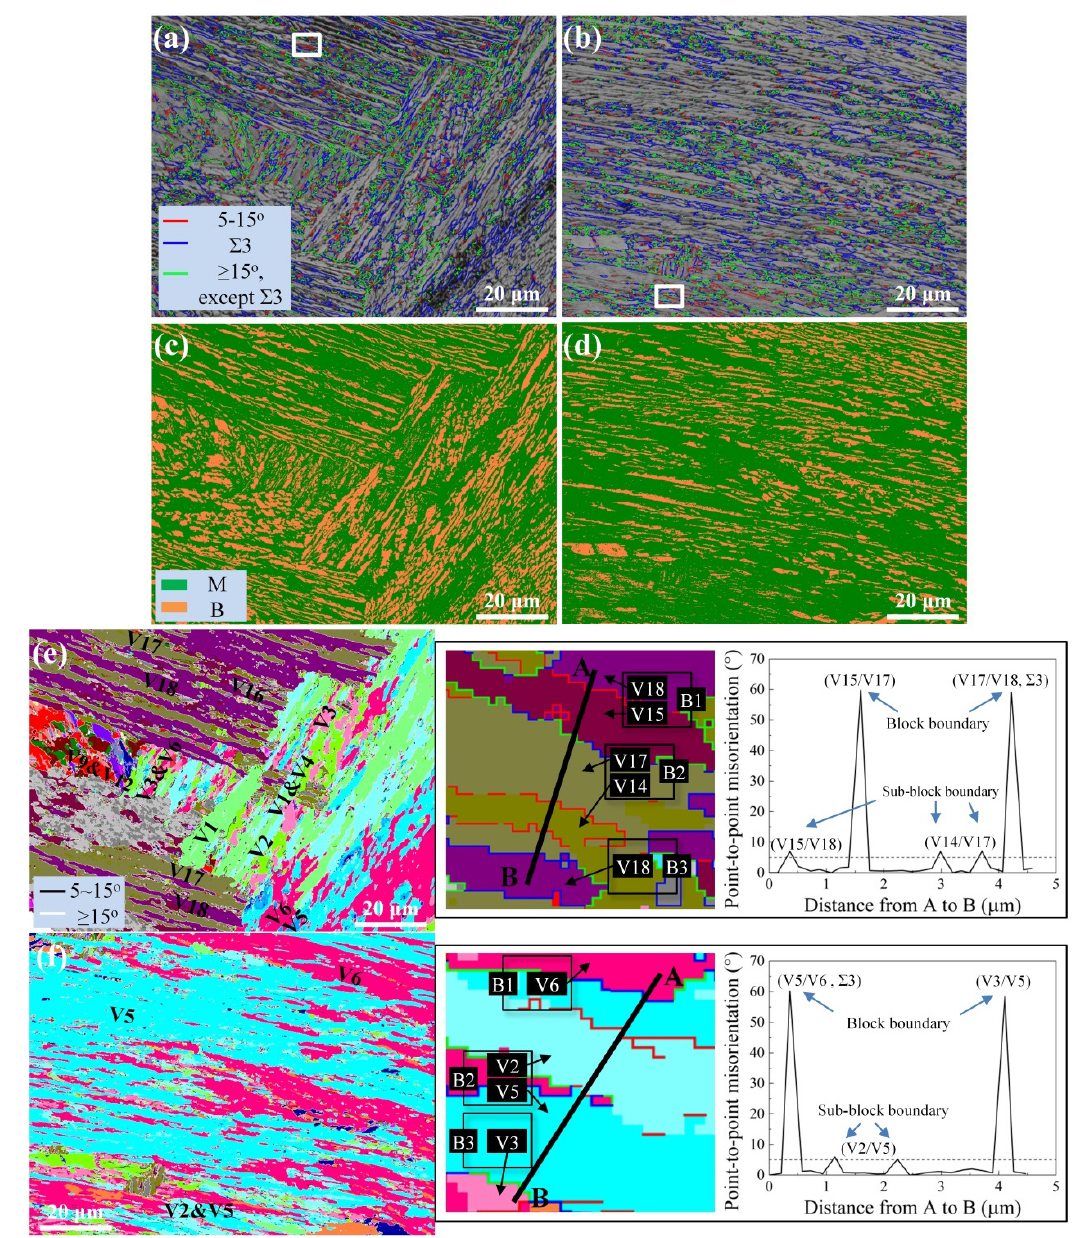
Figure 8. ( a , b ) GB and BC maps, ( c , d ) BC maps based on the Gaussian fit and ( e , f ) variant pairing: ( a , c , e ) IT698 and ( b , d , f ). The insets show the variant pairing of the selected region in ( e , f ) and the corresponding point-to-point misorientation profile from A to B. Black arrows indicate variants and blue arrows indicate the types of boundary. (V1: variant 1; …V24: variant 24. B1: block 1; …B3: block 3.)